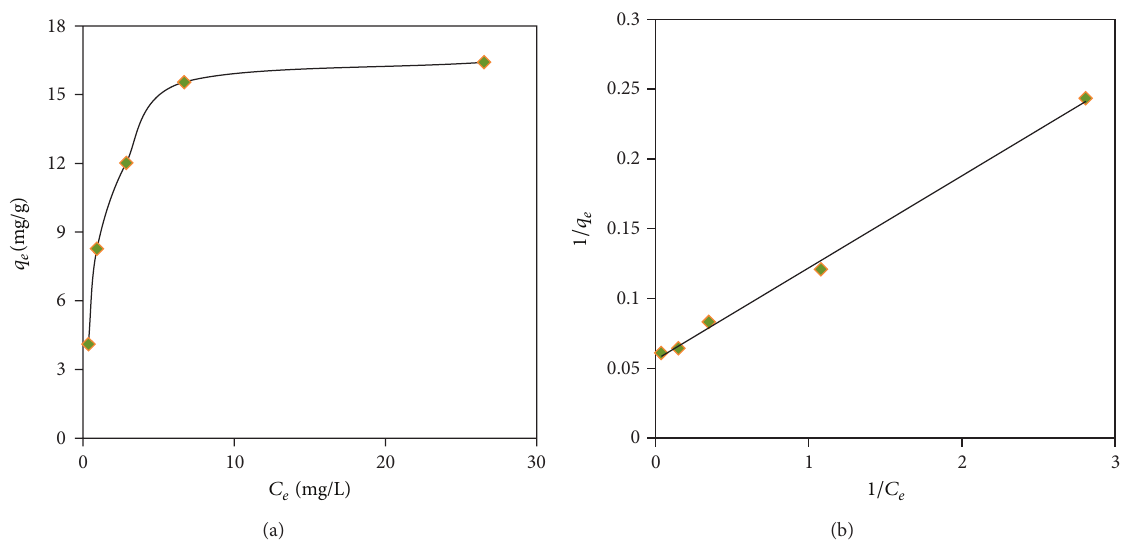
Figure 8: Plots of (a) 𝑞 𝑒 versus 𝐶 𝑒 and (b) the linearized form of the Langmuir model for the adsorption of AB1 onto the CTS/feldspar composite; pH 3 and 15 ∘ C.